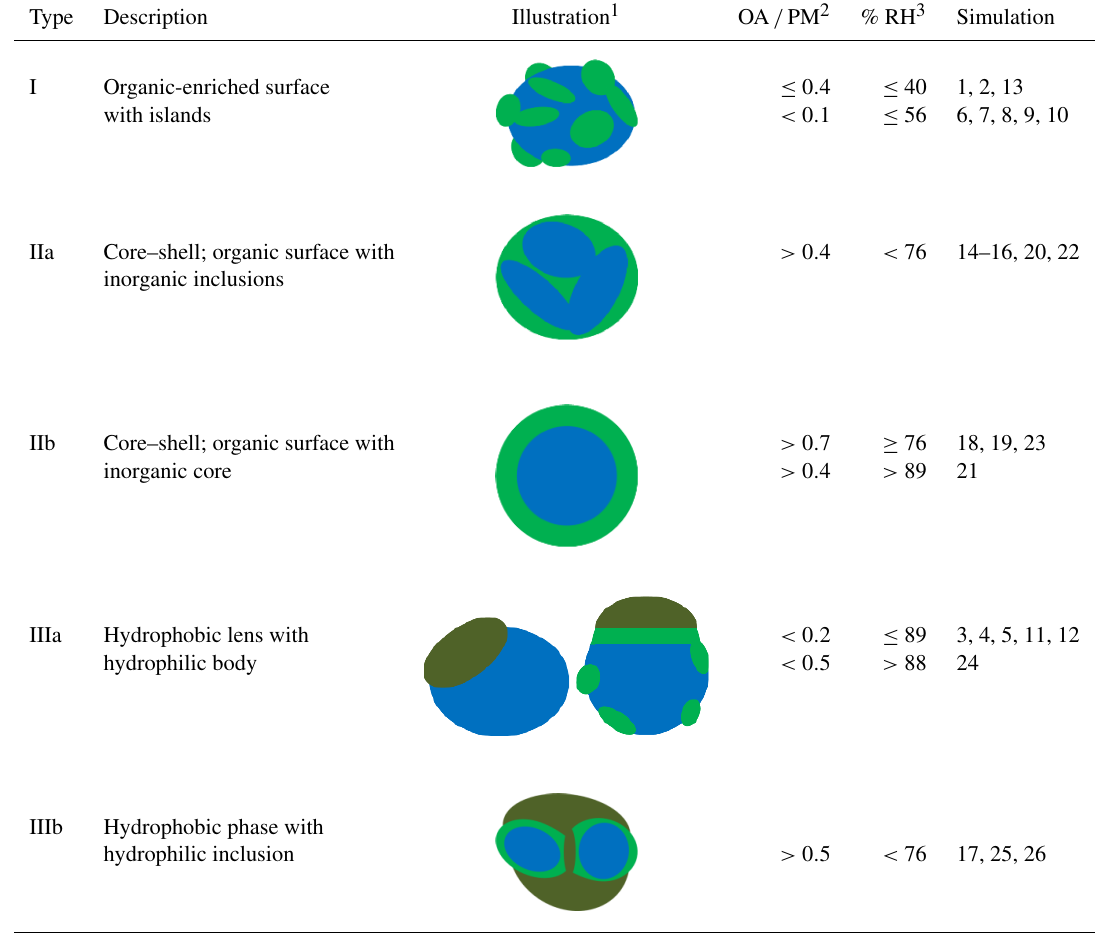
Table 2. Description and schematic illustration of the morphologies identified in the simulated atmospheric nanoparticles.